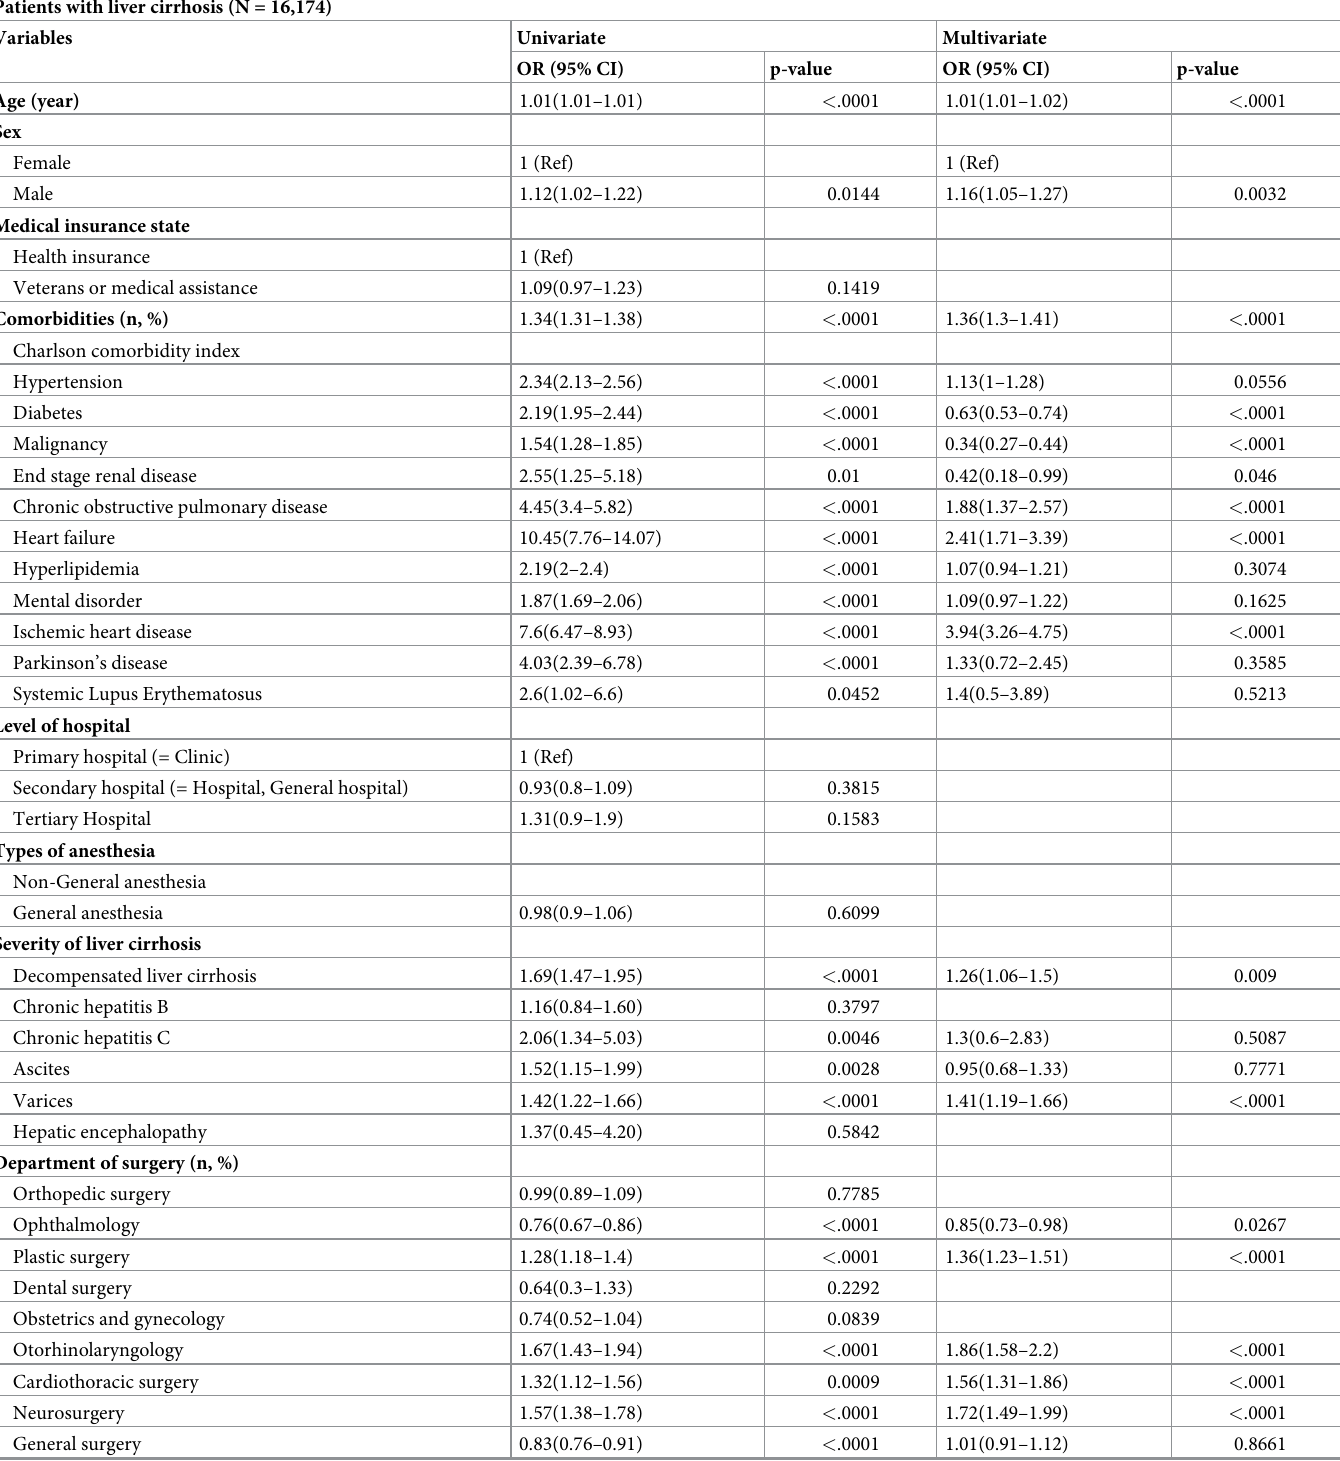
Table 5. Multivariate logistic regression predicting adverse outcome (mortality or post-operative complication) in patients with liver cirrhosis. Patients with liver cirrhosis (N =